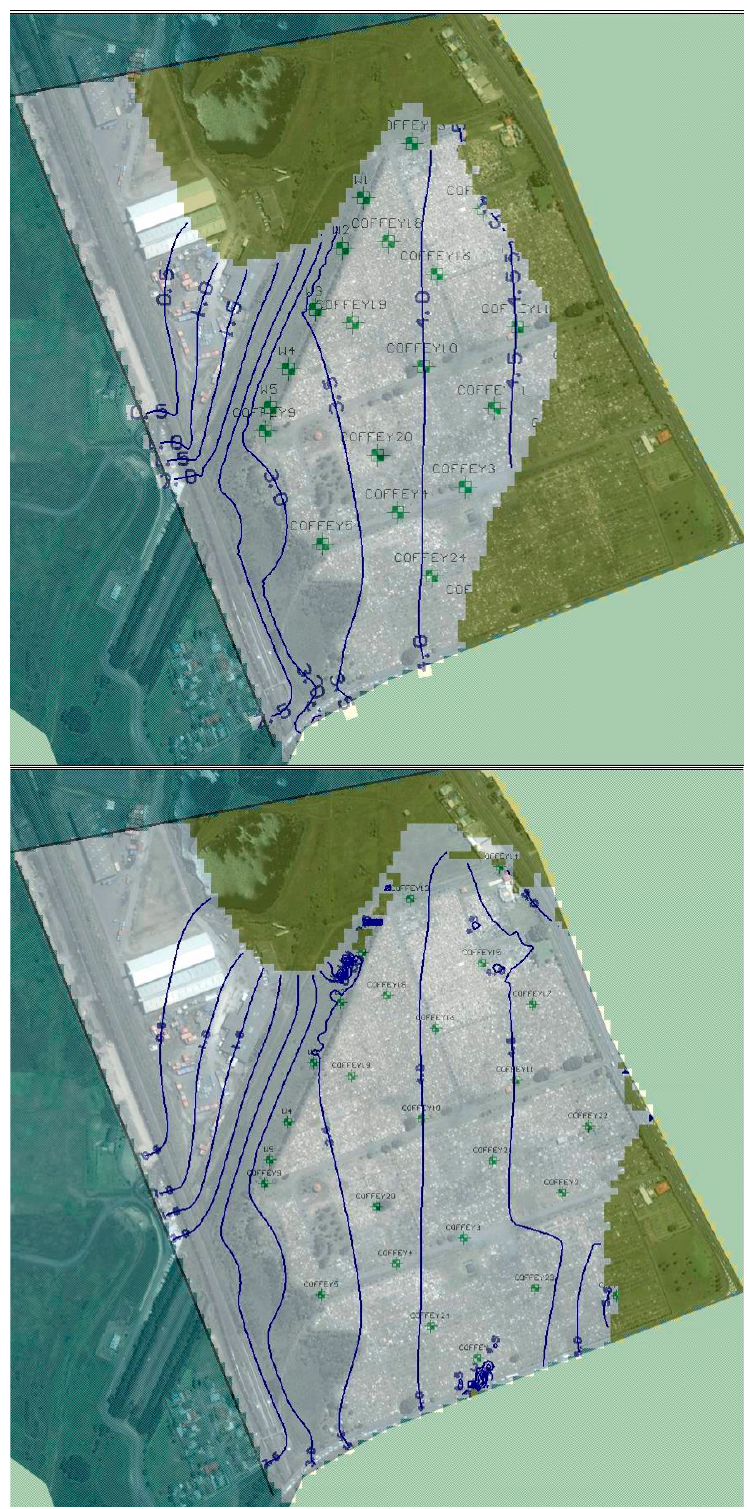
Figure 9. Scenario 1—Calibrated steady state potentiometric surface for Layer 1 and Layer 2. Observation Piezometer in green.